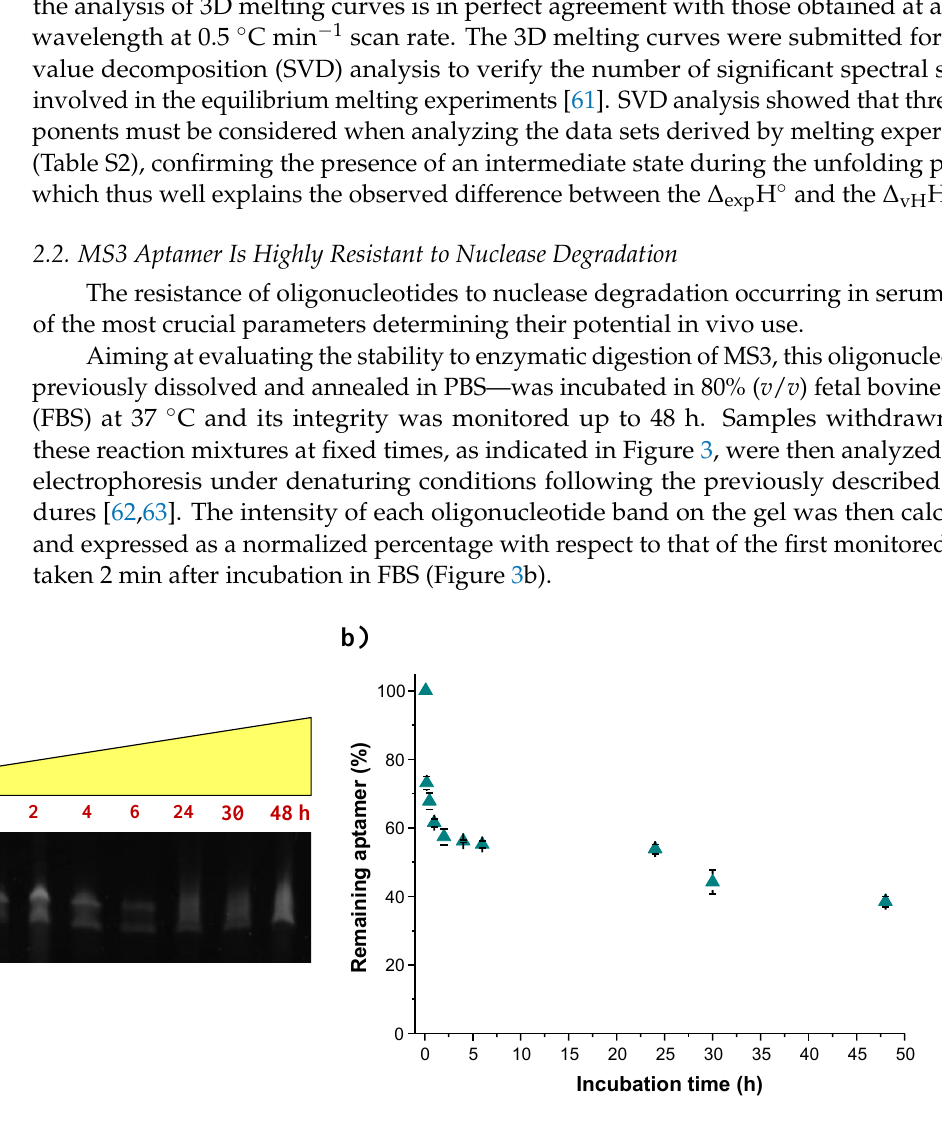
Figure 3. Enzymatic resistance experiments performed on MS3 incubated in 80% fetal bovine serum (FBS) as monitored by 20% denaturing polyacrylamide gel electrophoresis up to 48 h (time points: 0.1, 0.2, 0.5, 1, 2, 4, 6, 24, 30 and 48 h). ( a ) Representative 20% denaturing PAGE (8 M urea). Samples were loaded at 3 μM concentration, and the gel was run at a constant 200 V at r.t. for 3.5 h in TBE 1× as running buffer. ( b ) Time-dependent degradation of MS3 in the presence of FBS. The intensity of the band corresponding to the intact oligonucleotide on the gel is expressed as percentage of the remaining intact aptamer with respect to that of the first monitored point and reported as a function of the incubation time. Data are reported as mean values ± SD (error bars) for multiple determina- tions.